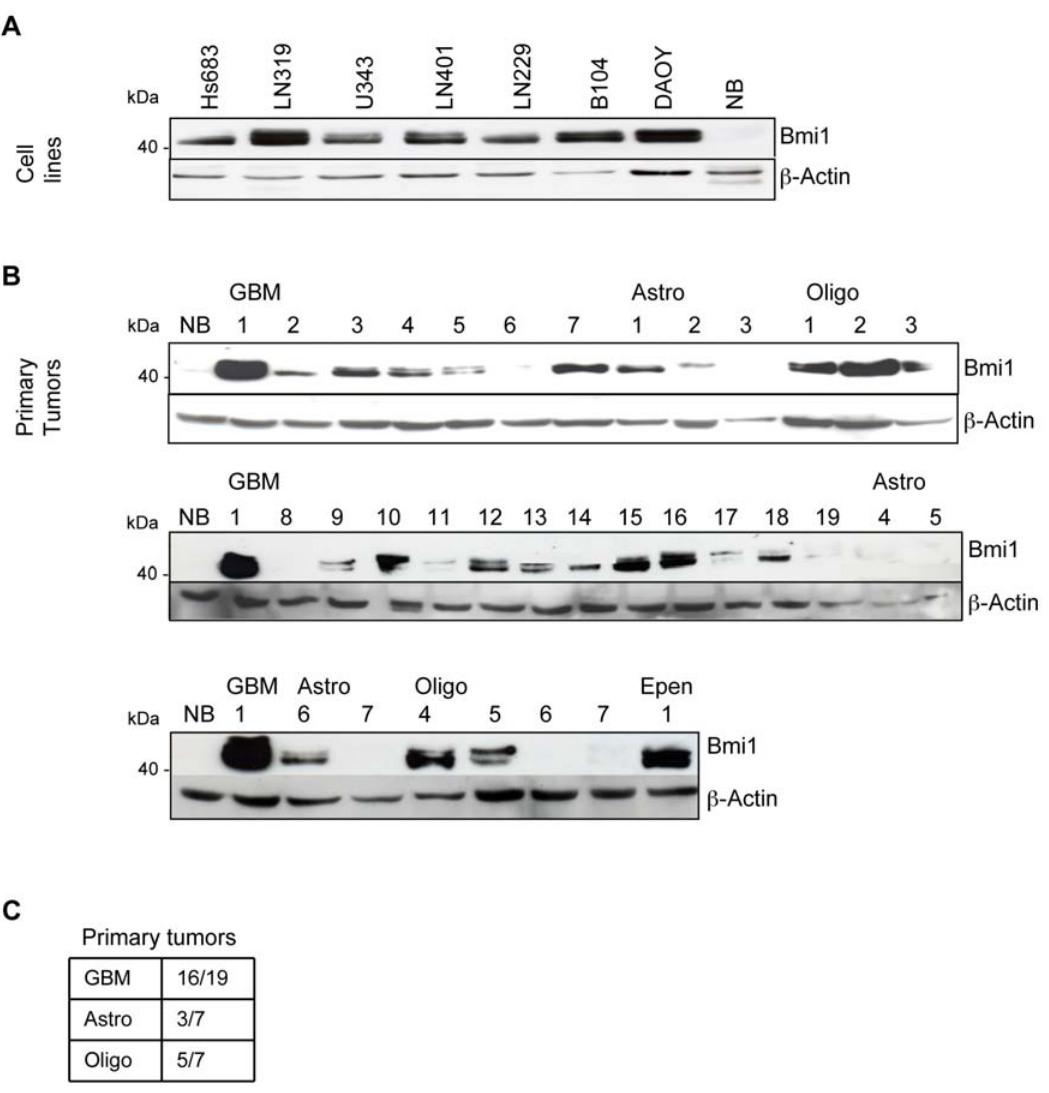
Figure 1. Bmi1 was highly expressed in GBM. Bmi1 expression in (A) GBM cell lines and (B) primary brain tumors. (C) Ratio of Bmi1-positive primary tumors. NB: normal brain. EPEN: